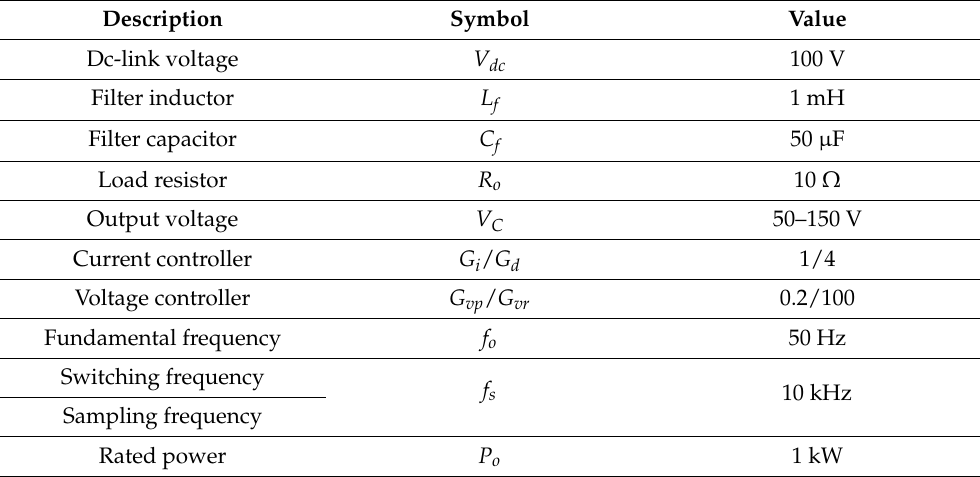
Table 1. System and Control Parameter Values.